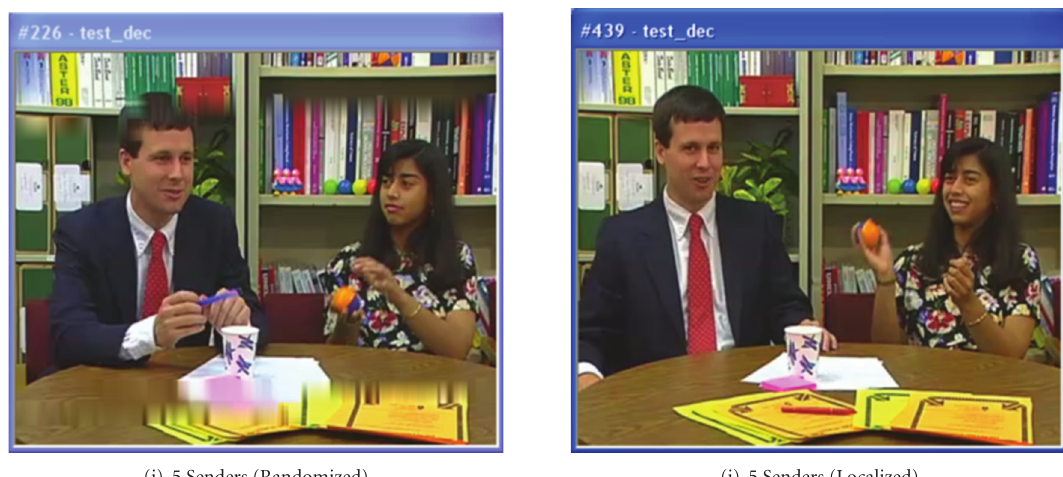
conditions are compared. The streams were coded and decoded with an H.264/AVC encoder/decoder of type